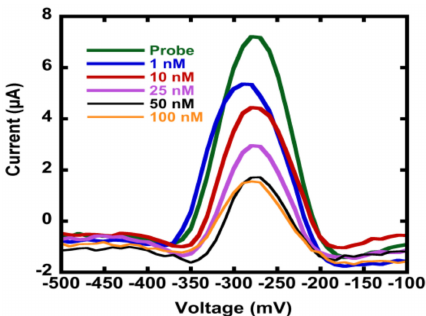
Figure A6. Square-wave voltammograms of probe DNA (26-mer) and probe/target DNA hybrid to show the detection limit of the probe functionalized np-Au MEA sensor upon exposure to different target concentrations. Decrease in the SWV peak indicates successful hybridization.